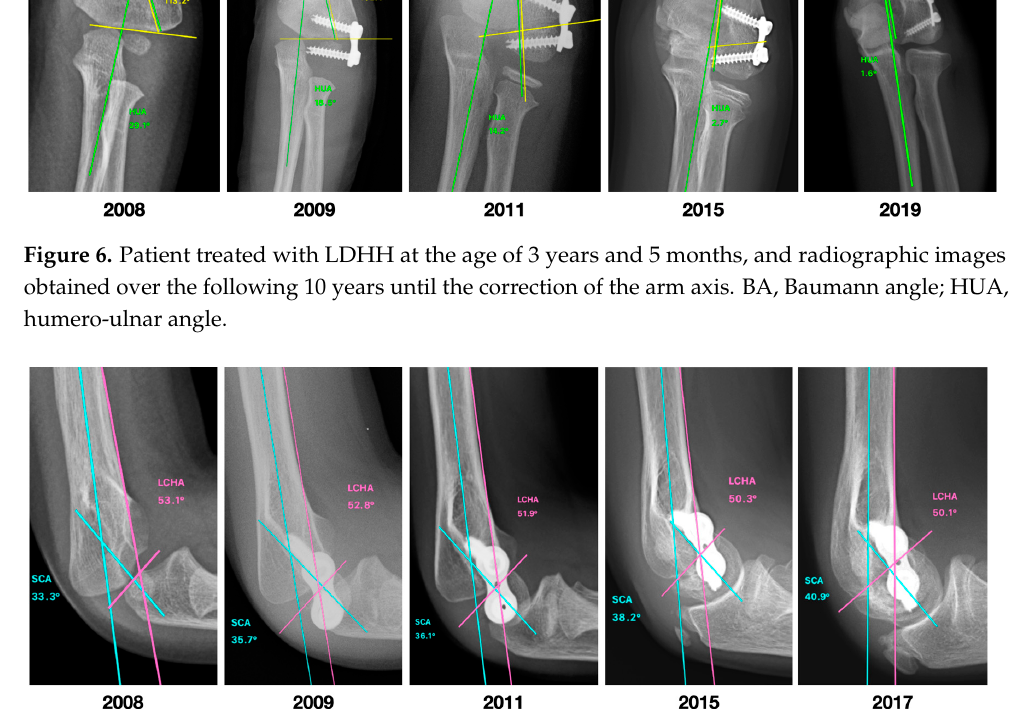
Figure 7. Lateral radiographs of the elbow of the same patient in Figure 5, showing an improvement in the radiological parameters, with values closer to normal in the last radiological control. SCA, shaft-condylar angle, LCHA, lateral capitellohumeral